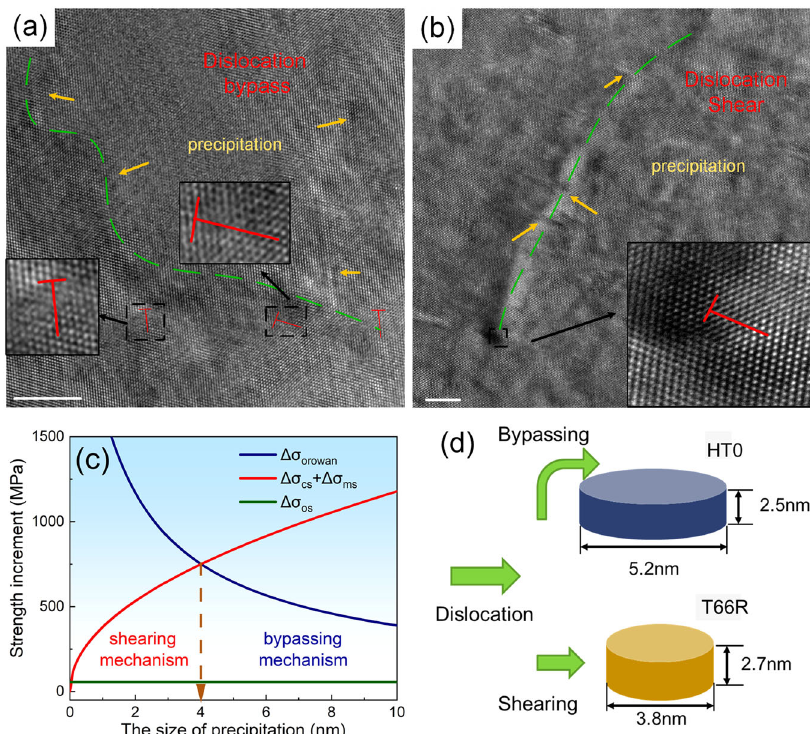
Fig. 8 Effect of the size of precipitates on the precipitation strengthening mechanism. a Dislocation morphology near precipitates after 5% plastic deformation in the HT0 process, ( b ) dislocation morphology near precipitates after 5% plastic deformation in the T66R process, ( c ) the change in Δσ orowan , Δσ cs + Δσ ms and Δσ os with the size of precipitates, and ( d ) the change in dislocation motion type. Scale bars: 5 nm ( a , b